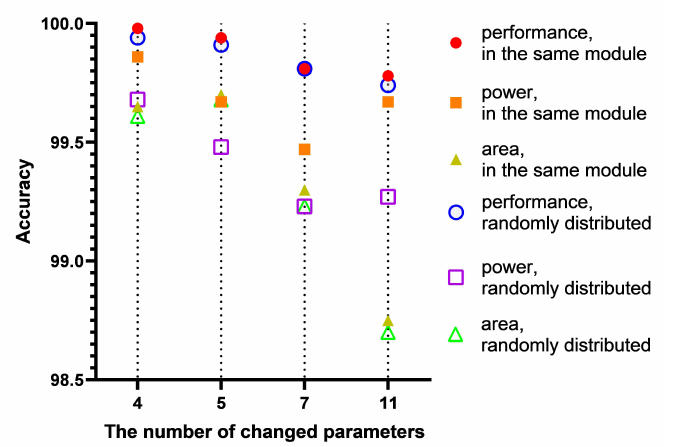
Figure 5. MNL-PM on the same number of changed parameters in the same modules and randomly